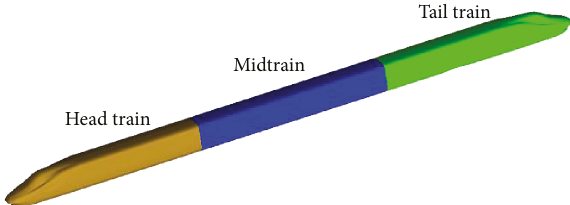
Figure 1: Simpli fi ed geometric model of the adopted high- speed train.